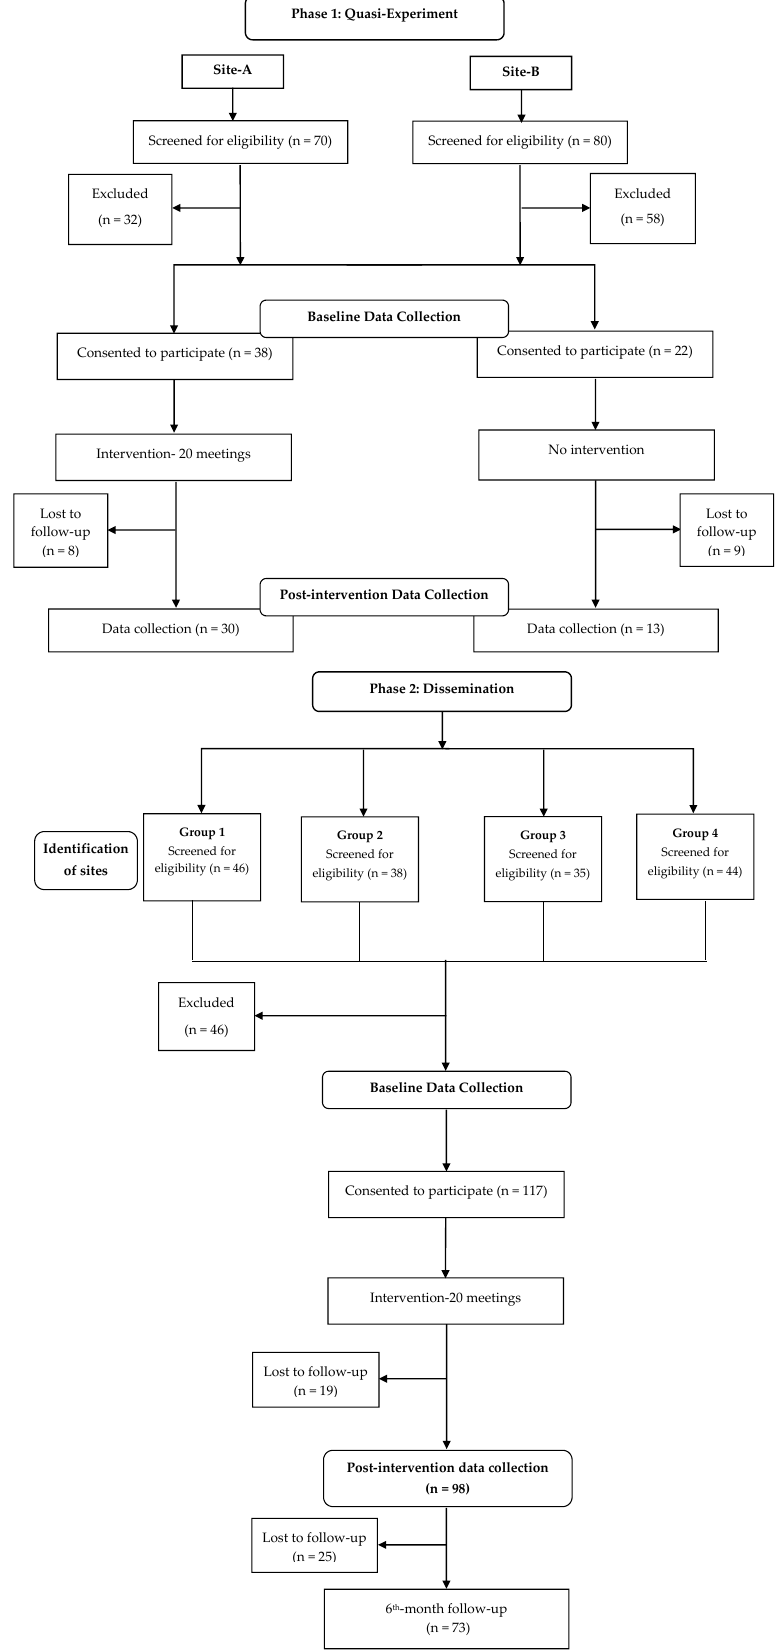
Figure 1. Flow chart of the study